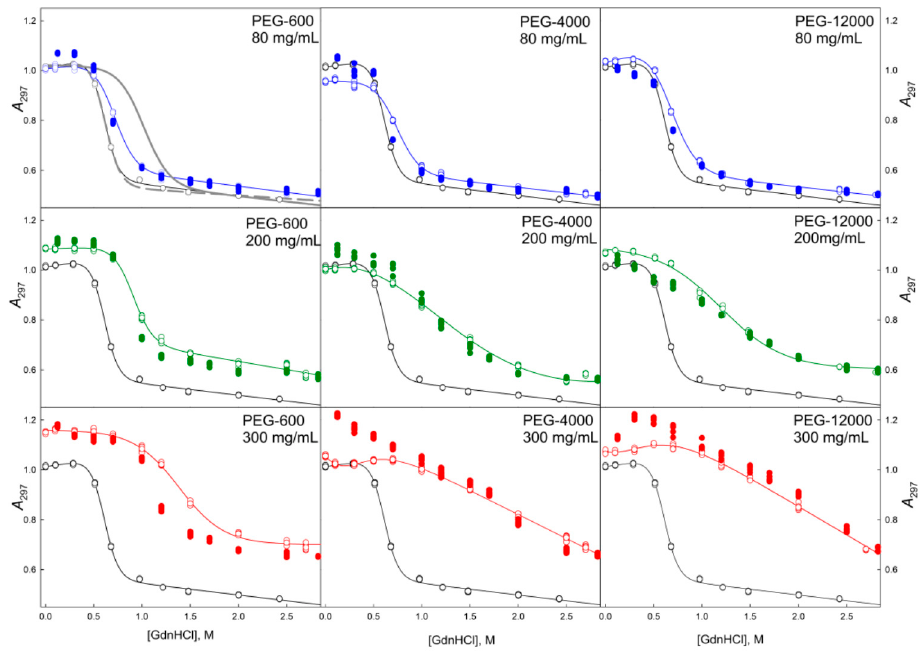
Figure 4. Unfolding/refolding transitions of GGBP induced by GdnHCl in the presence of different concentrations of PEGs of various molecular weights recorded as the GdnHCl dependencies of parameter A = F 320 / F 365 . The excitation wavelength was 297 nm. The unfolding of GGBP is represented by open symbols, whereas refolding is shown by closed symbols. The black curve is equilibrium GdnHCl-induced unfolding of GGBP in the absence of crowding agents. The gray curve in the upper left panel represents the equilibrium GdnHCl-induced unfolding transition of the glucose bound GGBP. The gray dashed curve in the same plot shows the equilibrium GdnHCl-induced unfolding of the GGBP sample prepared by the pre-incubation in 2.5 M GdnHCl solution followed by the extensive dialysis.